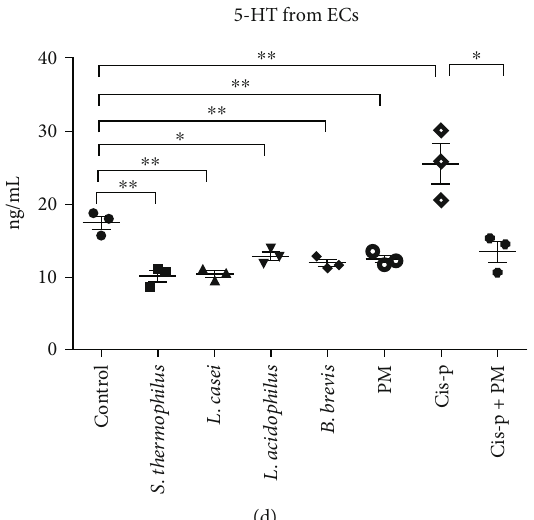
Figure 5: Probiotic mixture reduced 5-HT-associated bacteria and inhibited 5-HT secretion by RIN-14B cells. (a) Correlations between the abundances of di ff erential species and colonic 5-HT level. Abundances of Clostridium cluster IV (b) and XIVa (c) in the feces of rats in di ff erent groups detected by quantitative PCR. Data are presented as the mean logarithm of bacterial colony-forming units (CFU) per gram of feces. (d) Levels of 5-HT released from RIN-14B cells after exposure to various bacteria or cisplatin. Data are expressed as mean ± SEM ( n = 3 – 5): ∗ p < 0 : 05 , ∗∗ p < 0 : 01 , and ∗∗∗ p < 0 : 001